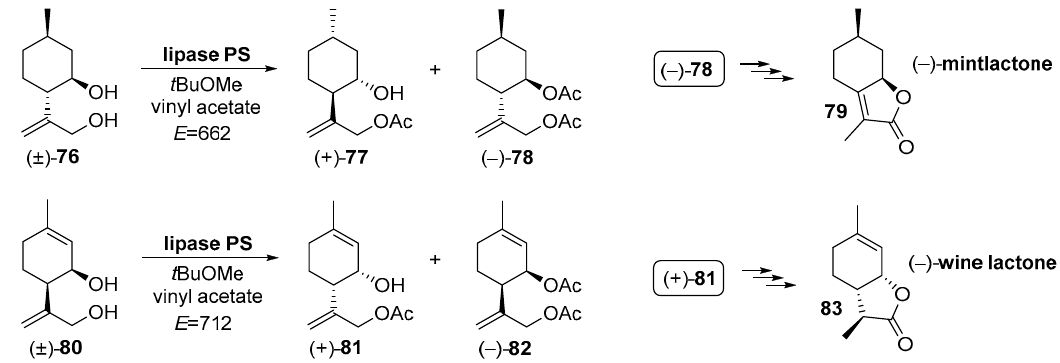
Figure 14. Lipase-mediated resolution of the racemic p -menthan-3,9-diol derivatives 76 and 80 and use of the chiral building blocks 78 and 81 for the enantioselective synthesis of the natural flavors mintlactone ( 79 ) and wine lactone ( 83 ), respectively.